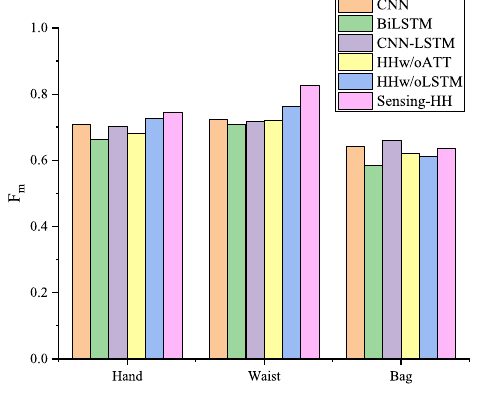
Figure 6. F m of six models on different class in waist scene.